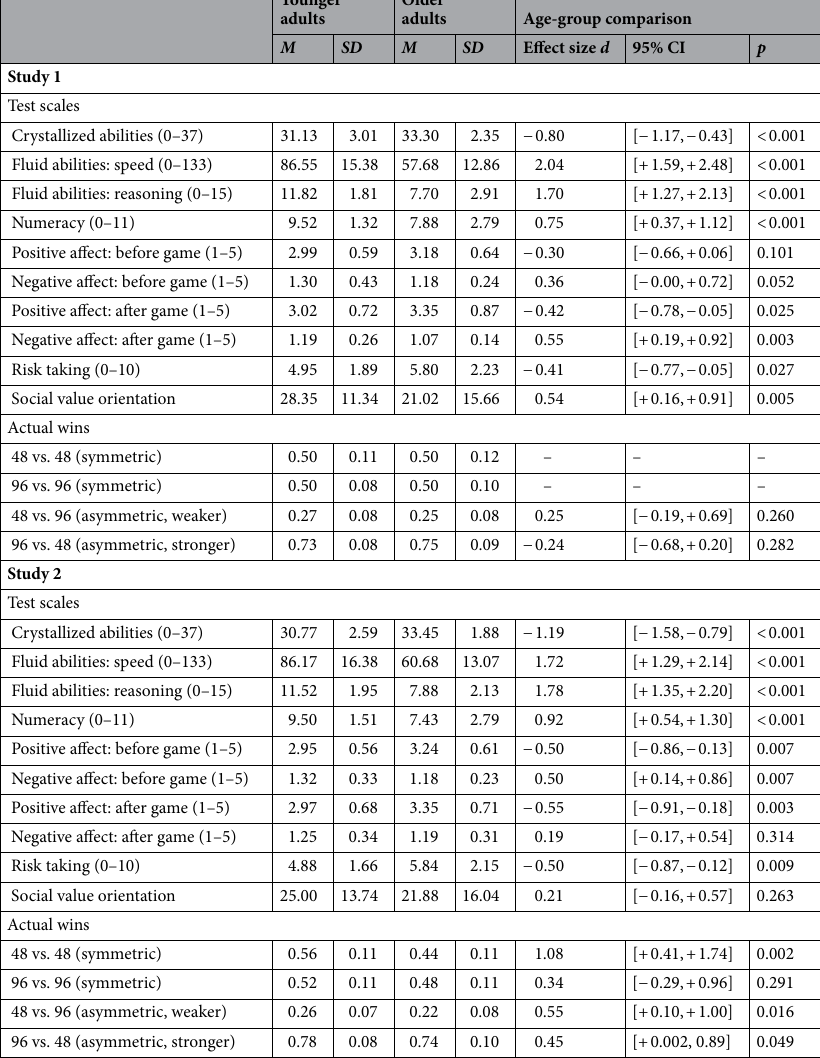
Table 2. Test scales scores and actual wins for younger adults, older adults, and age-group comparisons. Actual wins = observed proportion of wins out of 25 rounds. Details of the test scales used in both studies are in the Supplemental Online